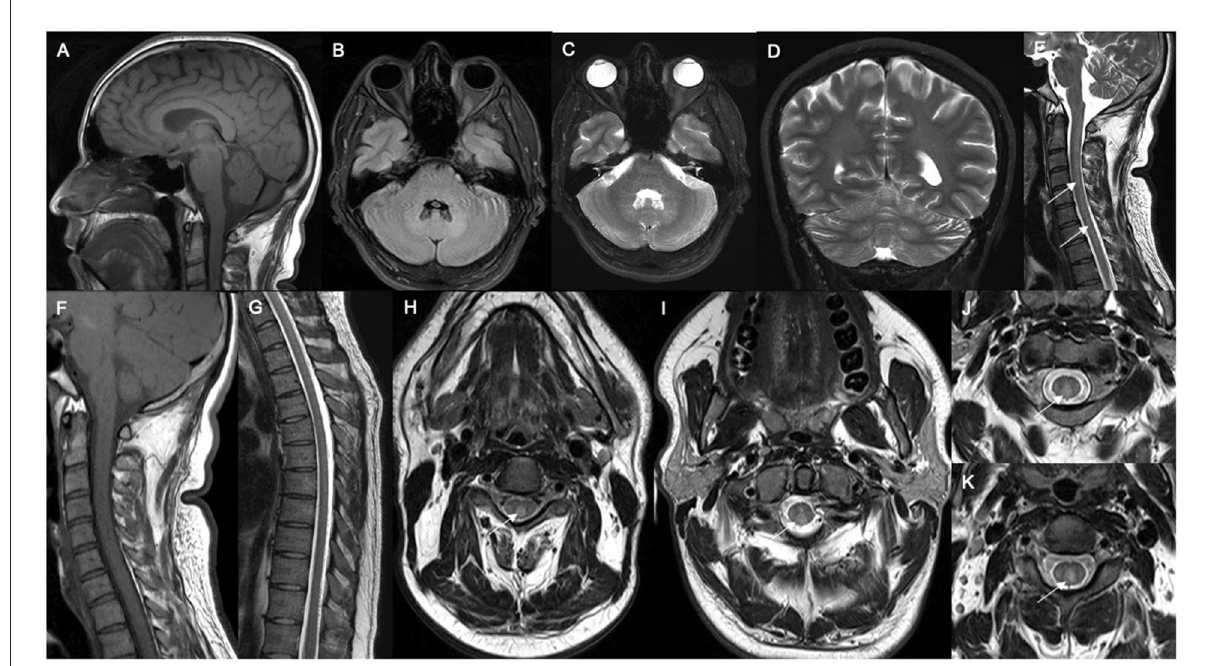
FIGURE6 Neuroradiological features in spinal CTX. (A) Sagittal brain MRI showed normal cerebellar and corpus callosum structure. Axial brain MRI showed mild hyperintensity in dentate nucleus in FLAIR (B) and T2W sequences (C) , as well as hyperintensity in dentate nucleus in coronal T2W imaging (D) . Sagittal spine MRI showed hyperintense (white arrows) in T2W imaging (E) and isointense change in the dorsal column of the cervical spinal cord in T1-weighted imaging (F) . Sagittal thoracic spine MRI showed normal structure (G) . Axial cervical spine MRI showed marked hyperintensity of the dorsal column (white arrows) in T1W (H) and T2W imaging (I–K)